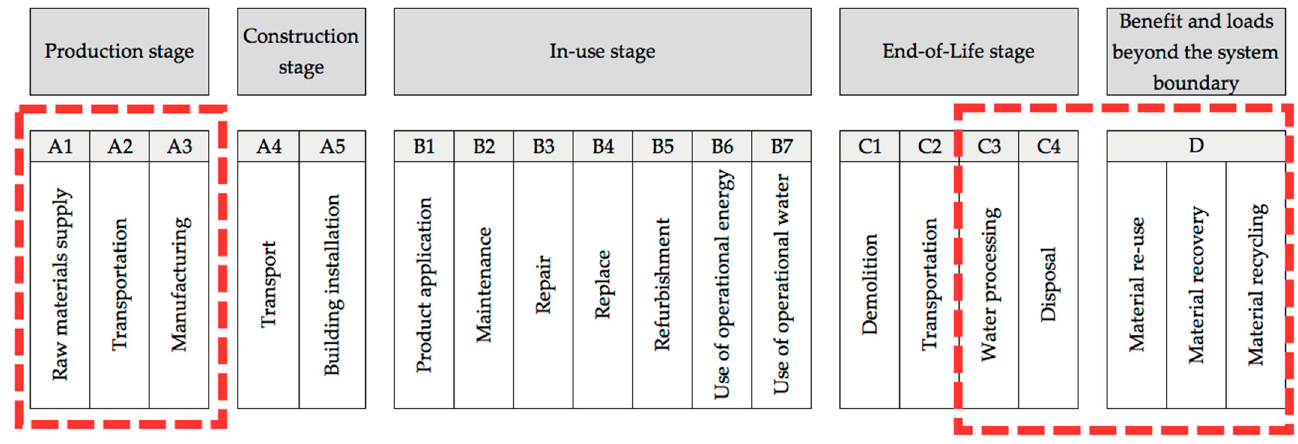
Figure 3. Selected building life stages of the investigated metal cladding products.